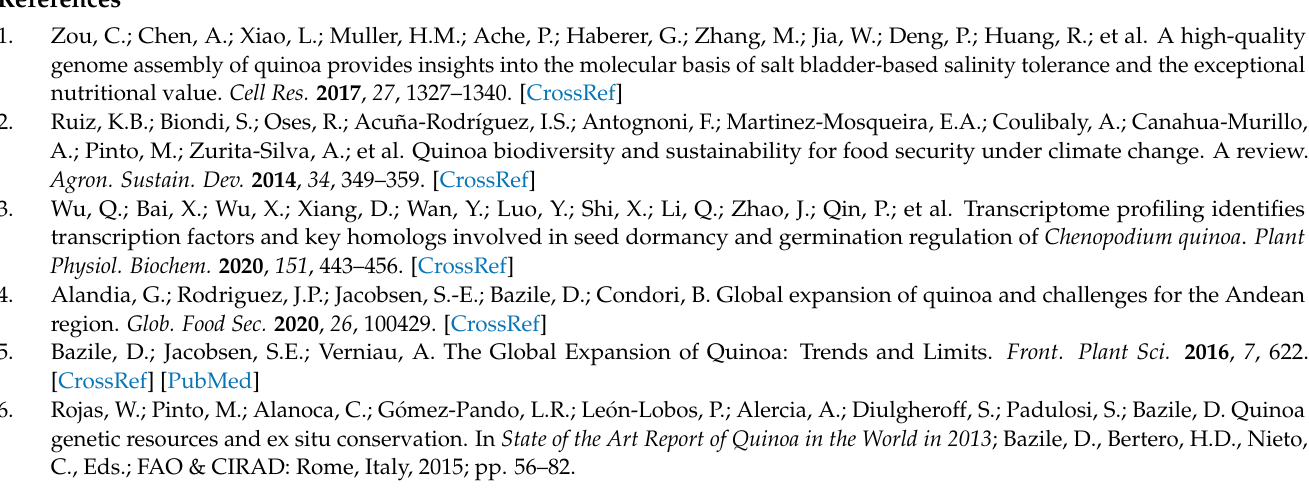
Figure S2: Fresh and Dry weight of 25 panicles. Figure S3: Correlogram of variables measured. Figure S4: Pictures of seeds of the different cultivars harvested and analyzed in this study. Table S1: Direct effects of predictor variables of the first-, second-, third-, and fourth-order on germination rate, tolerance, and variance inflation factor of the path analysis. Table S2: Direct effects of predictor inflation factor of the path